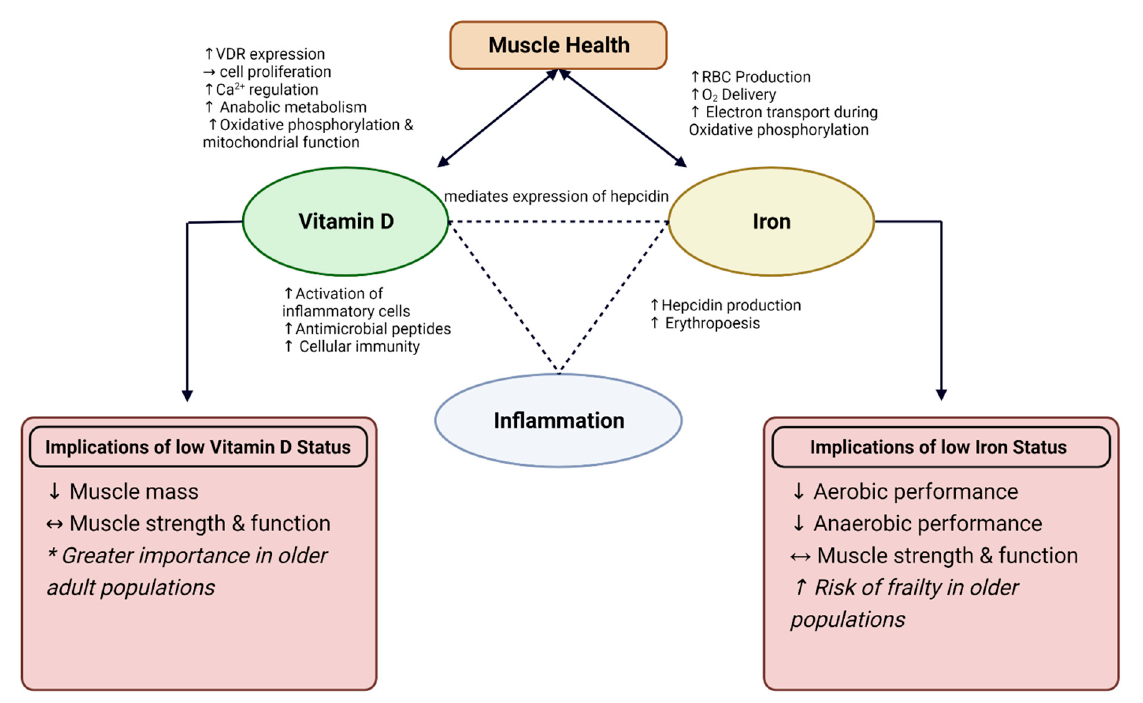
Figure 1. Interaction between Vitamin D and Iron on muscle health and role for inflammation. Depicted implications of low Vitamin D and Iron status on muscle health and performance. VDR = Vitamin D Receptor; RBC = red blood cell, Ca 2+ = calcium; O 2 = oxygen; ↑ = increase; ↓ = decrease; ↔ = conflicting results. * More profound results observed in interventions with older adults.